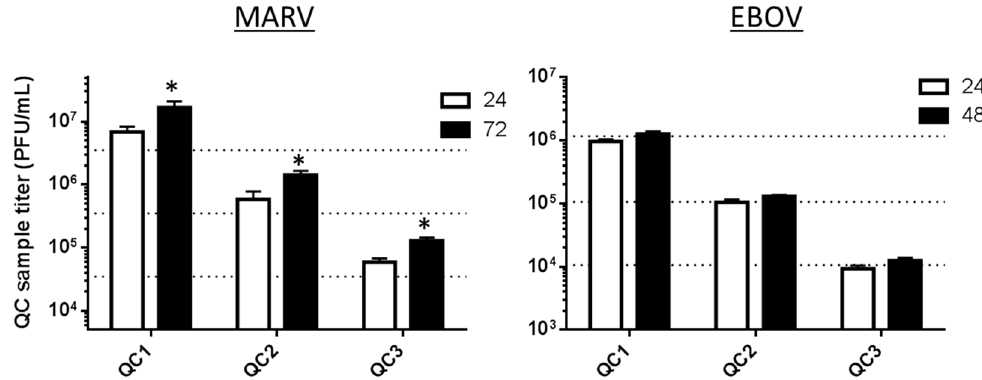
Figure 7. Use of cells at 24 or 48 h post-seeding provides accurate titer data for the EBOV validated plaque assay, but use at 72 h fails in the MARV assay. The bars represent average measured titers for QC1, QC2 or QC3 for MARV or EBOV, measured on cells plated at 24, 48 or 72 h prior to infection. The three horizontal dotted lines plot the nominal titers of MARV and EBOV QC1, QC2 and QC3. Those nominal titers are presented in Tables 1 and 2. The * indicates failed runs for MARV tested on cells plated 72 h before use.